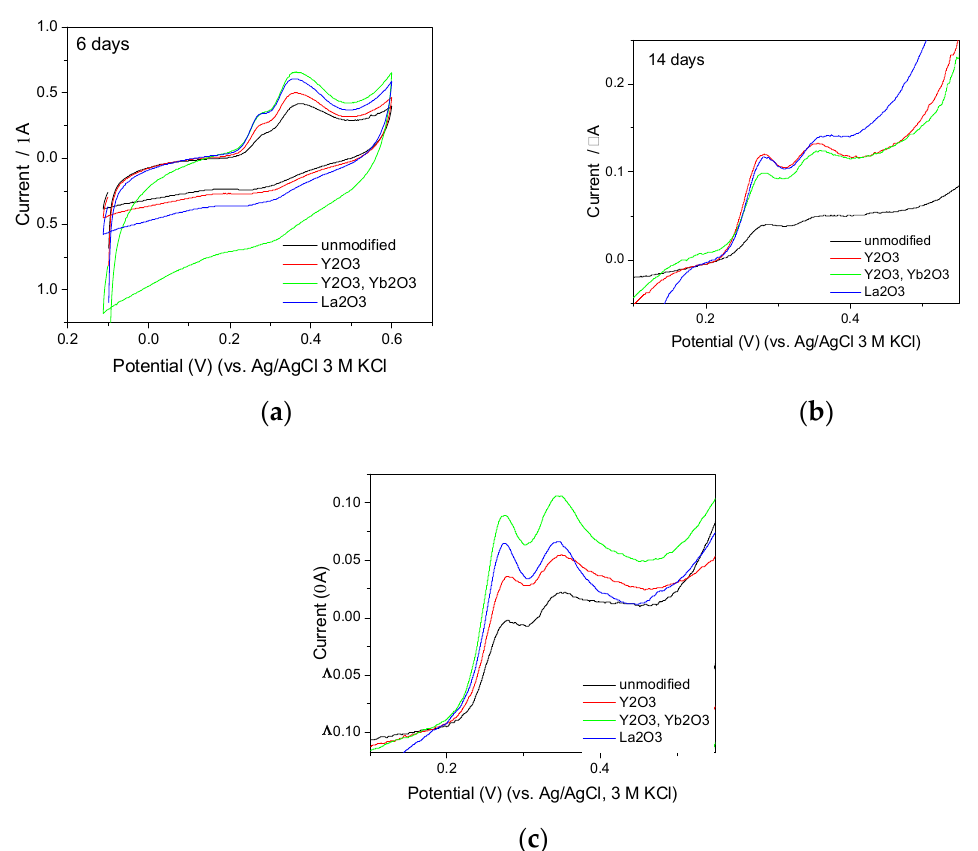
Figure 10. Cyclic voltammograms recorded by unmodified and modified GC n /PDMS electrodes in ( a , b ) 20 or ( c ) 200 times diluted GT1 extracts, stored in in the dark in closed vessels for ( a ) 6, ( b ) 14, or ( c ) 0 days. ( b , c ) Magnified view of the sections of voltammograms presented to highlight the details of the recorded signals. Full voltammograms are shown in Figure S3. Supporting electrolyte: 0.1 M acetate buffer (pH = 4.5). Scan rate: 100 mV/s.